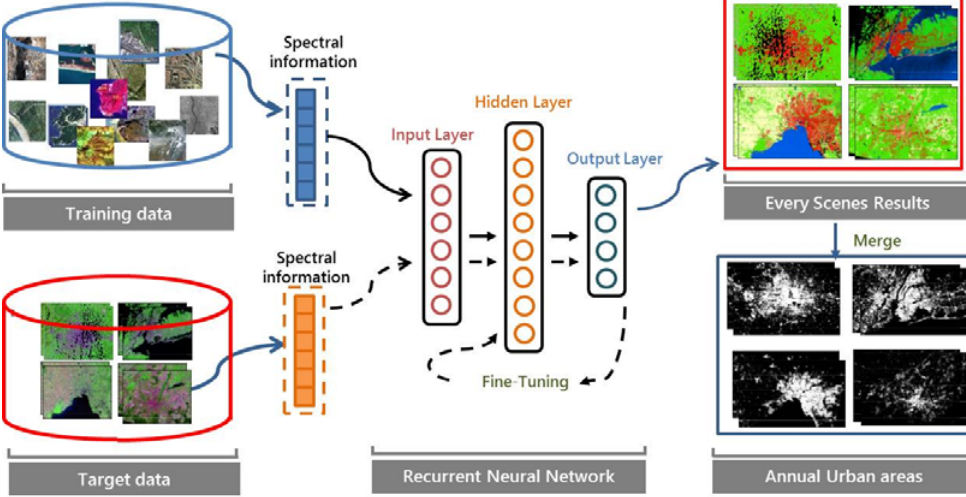
Figure 3. Flowchart of the proposed urban extraction framework. Solid black arrows represent training step, in which the model is initialized by feeding in labeled source data during offline training. Dotted black arrows indicate online optimization steps in which the initial model is fine-tuned, rendering it more specialized for new target data. Blue arrows represent input and output processes.